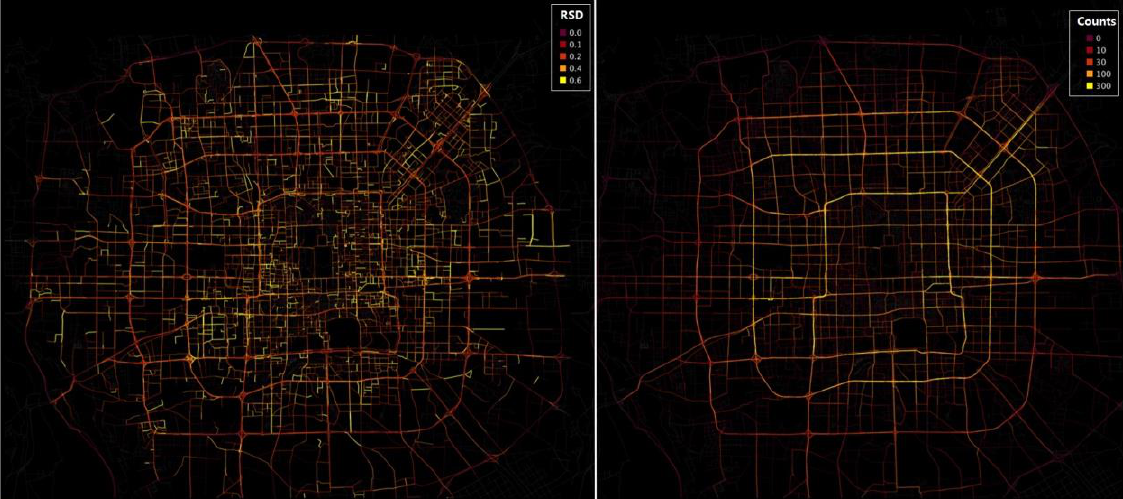
Figure 4. Relative Standard Deviation (RDS) of speed estimation (left) and number of speed estimations (sample size) in each link (number of taxi GPS traces used to estimate link speed)